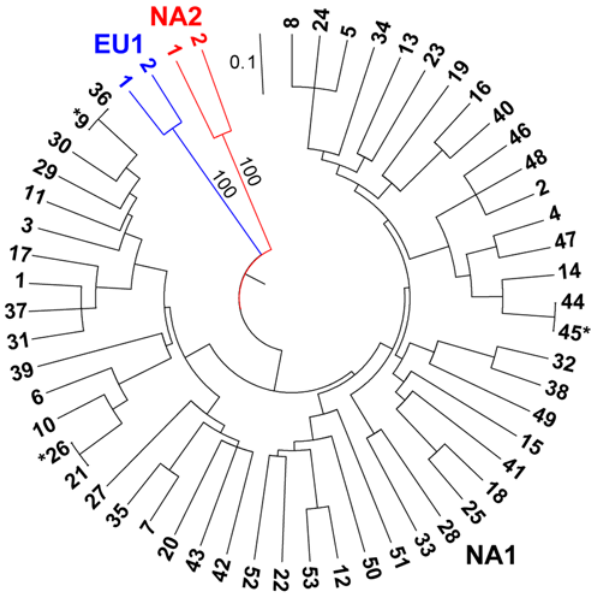
Figure 1. UPGMA dendrogram of genetic distance among all observed multilocus genotypes. Multilocus genotypes (MGs) are labeled as in Table S2 for NA1 isolates. Only two NA2 and EU1 multilocus genotypes were found. NA1 genotypes with null alleles are marked with asterisks. Support values greater than 70% using 1,000 bootstrap samples are